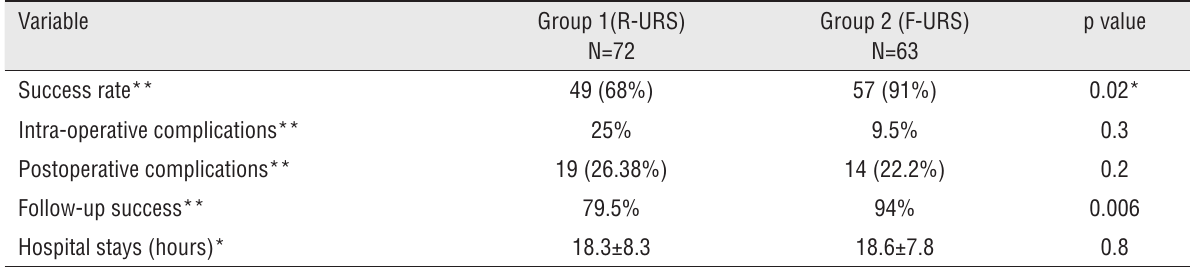
Table 2 - Success rate, operative and postoperative data of study